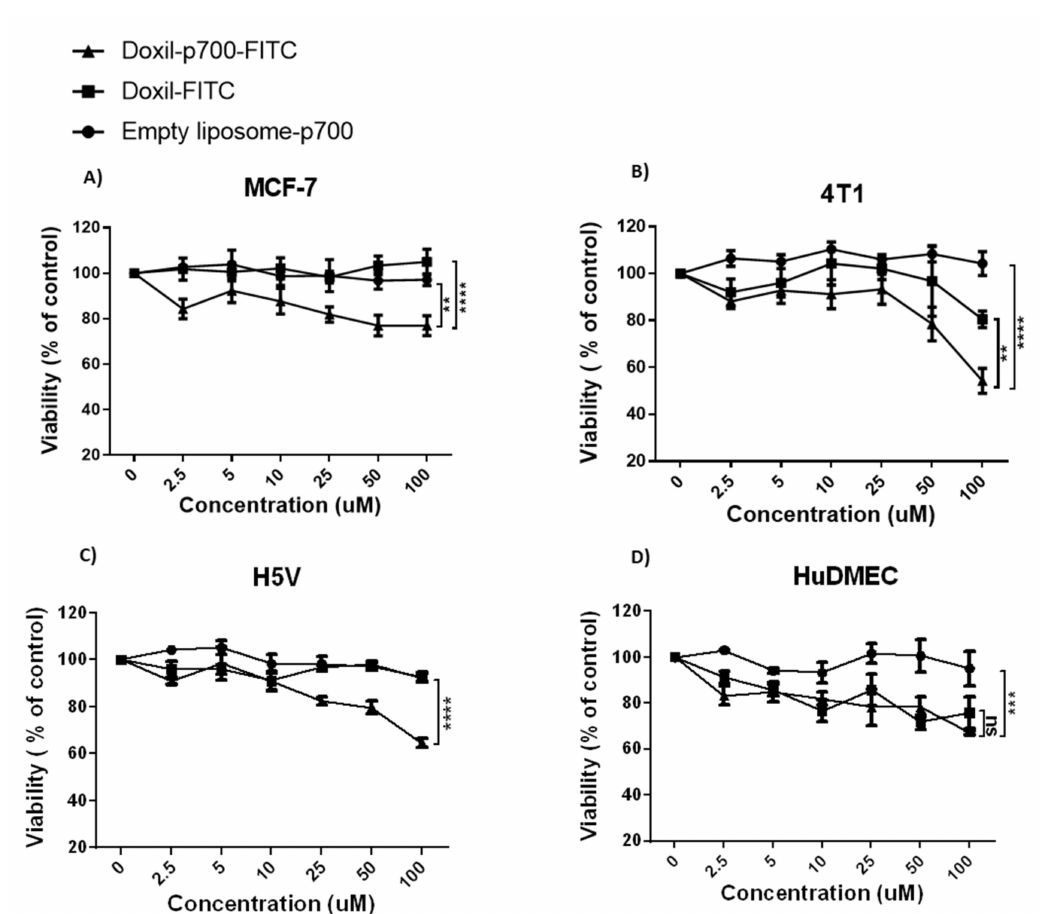
Figure 5. Effect of increasing concentrations of empty liposome—p700 FITC, Doxil-FITC and Doxil-p700-FITC on cell viability. 4T1 ( A ), MCF-7 ( B ), H5V ( C ) or HuDMEC ( D ) were treated for 4 h with the stated dose of each agent, as indicated in the key, washed and then incubated for a further 24 h in complete growth medium before performing an MTS cell viability assay. Data are means ± SEM, n = 3 (** = p < 0.01, *** = p < 0.001, **** = p < 0.0001 indicates significance, two-way ANOVA, multiple comparison